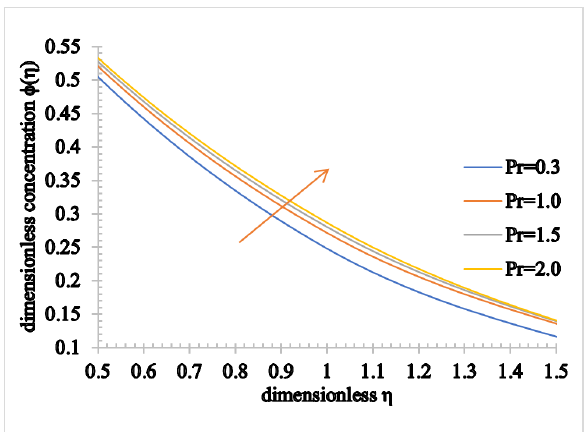
Figure 12: The concentration profile for increasing values of Pr.